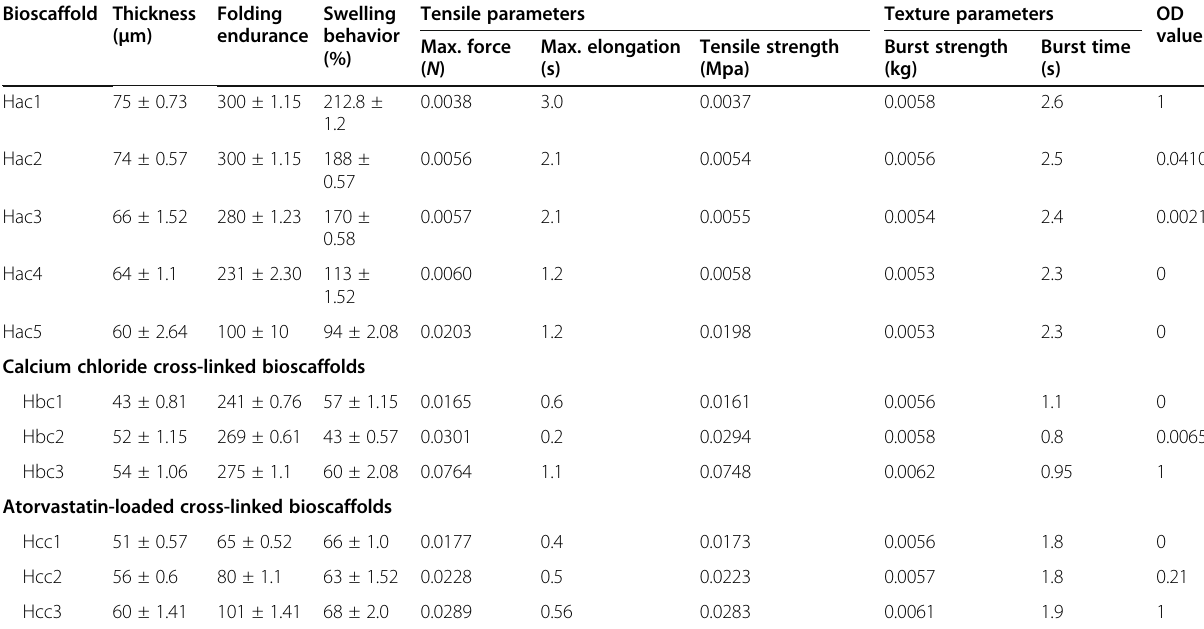
Table 2 Physicomechanical properties of prepared composite bioscaffolds Bioscaffold Thickness ( μ